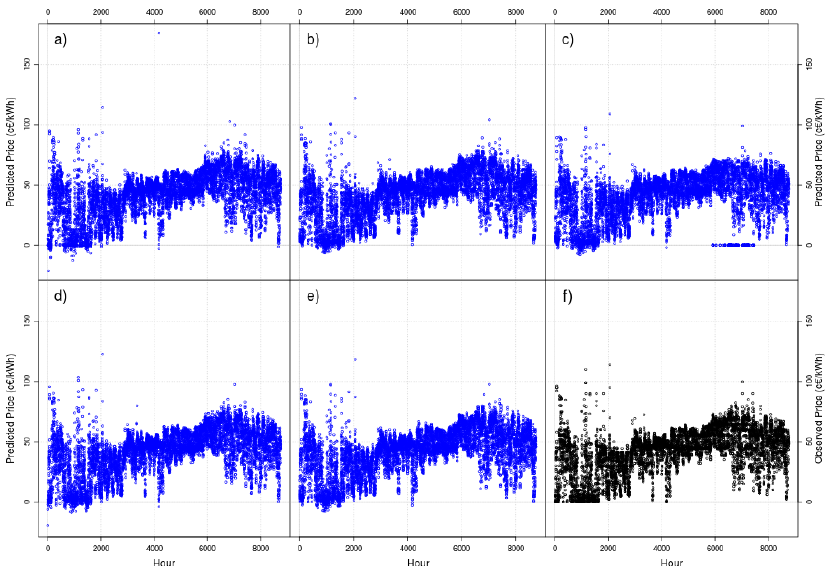
Figure 6. As blue points, one-hour ahead forecasts of DT with linear model for a moving window of 50 days. ( a ) Full model, ( b ) retire the oldest data, ( c ) retire the data discarded by active learning, ( d ) retire the oldest data and rejuvenate the particle set and ( e ) retire the data discarded by active learning and rejuvenate the particle set. As black points, ( f ) the 2014 real data to forecast. As we want to select another model, our final decision is to choose the full model (the best in terms of MAE), that is, DT with no extra treatment of the included data (full model: no retirement